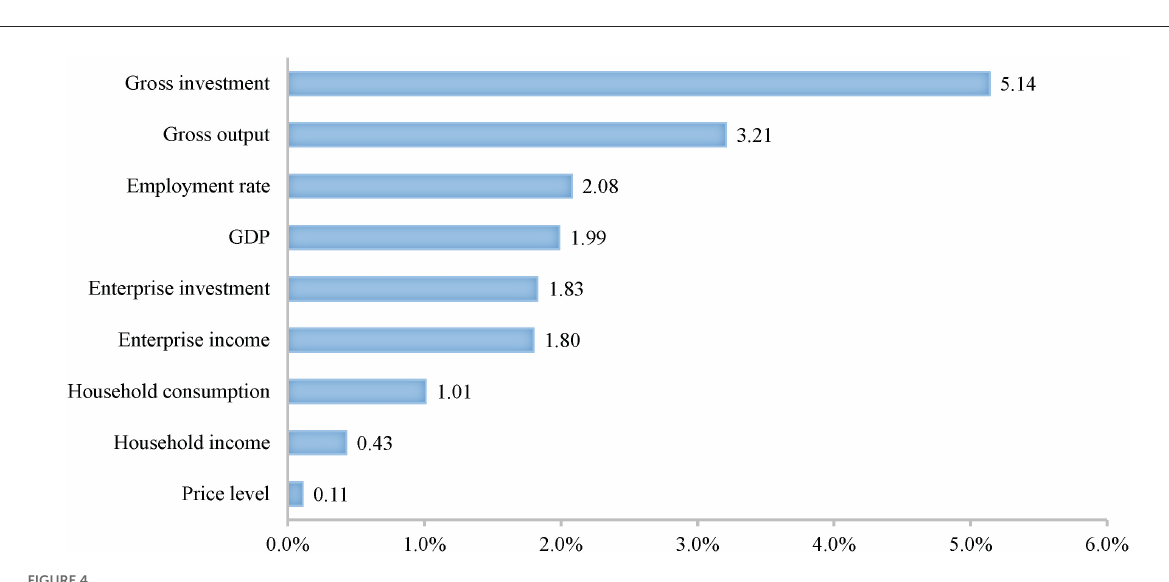
FIGURE4 The total effects of monetary policies on macro-economy (Unit: